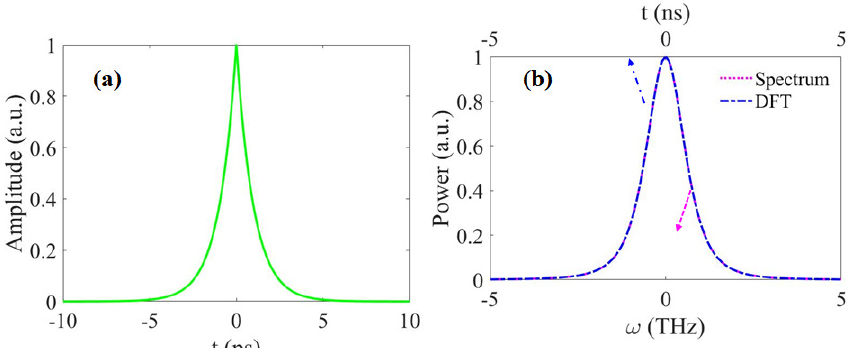
Figure 6. Time and frequency domains of the exponential pulse (Original pulse width = 2 ps): ( a ) Temporal profile of the exponential pulse; and ( b ) spectrum and dispersive Fourier transformation of the exponential pulse after the prism pair. The pink dotted line and blue dash-dotted line represent the spectrum and dispersive Fourier transformation of the exponential pulse, respectively. The light beam transfers in the prism pair with 20 m total length and 0.5 ◦ propagation angle, and the central wavelength of beam is fixed at 2.05 µ m.